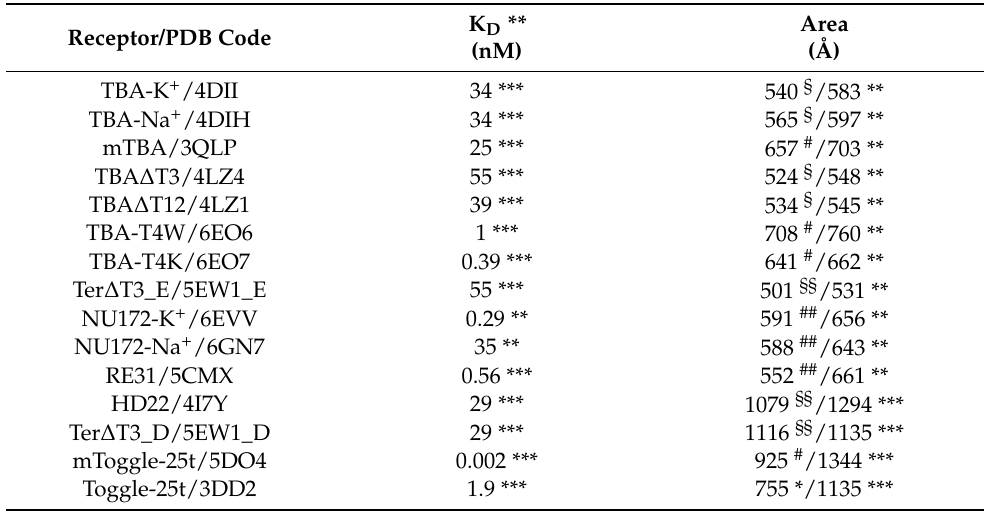
Table 2. List of anti-thrombin aptamers analyzed in this paper. The interface area and K D , as given in the literature, are